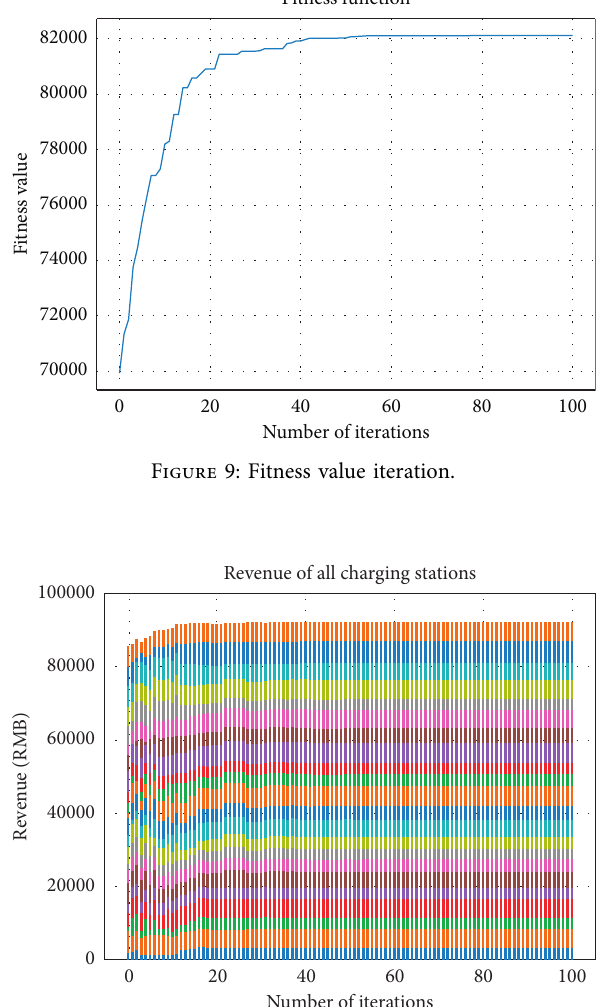
Figure 10: Revenue iteration of charging